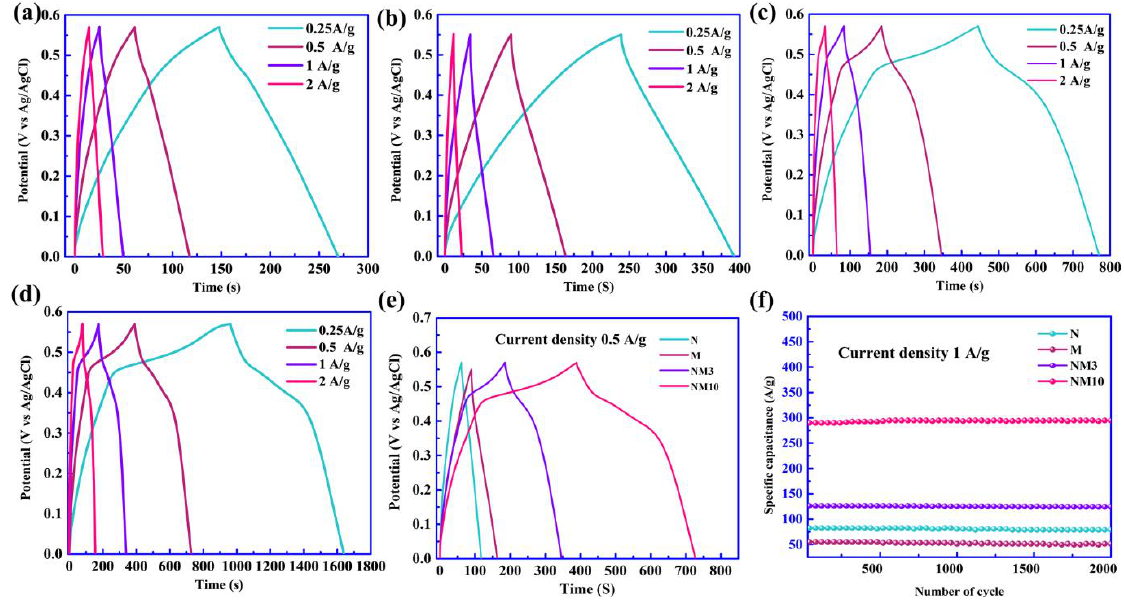
Figure 6. ( a – d ) GCD curves of N, M, NM3, and NM10, respectively, with various current densities; ( e ) comparison of GCD for N, M, NM3, and NM10 with 0.5 current density; ( f ) GCD stability of N, M, NM3, and NM10 at 1 A/g current density for 2000 cycles.